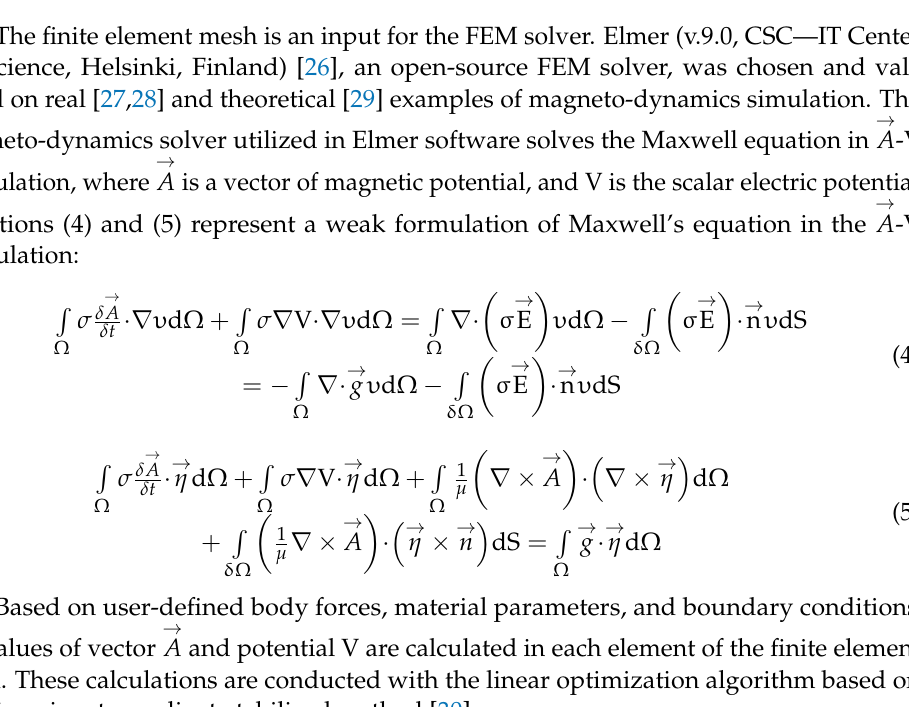
Figure 7. Exemplary finite element mesh for FEM-based forward tomography transformation in eddy current tomography. 1—model of the tested object, 2—model of the measuring coil, 3—model of the excitation coil.